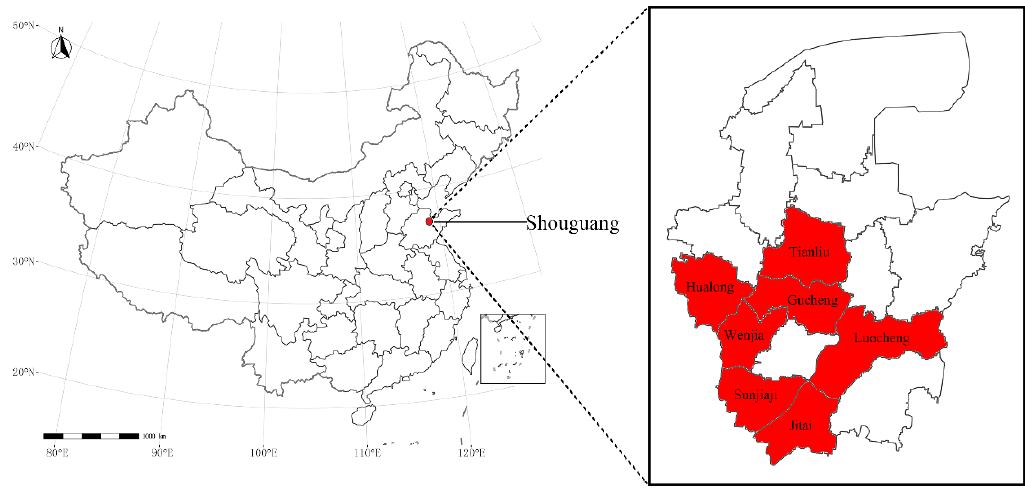
Figure 1. Map of survey site.